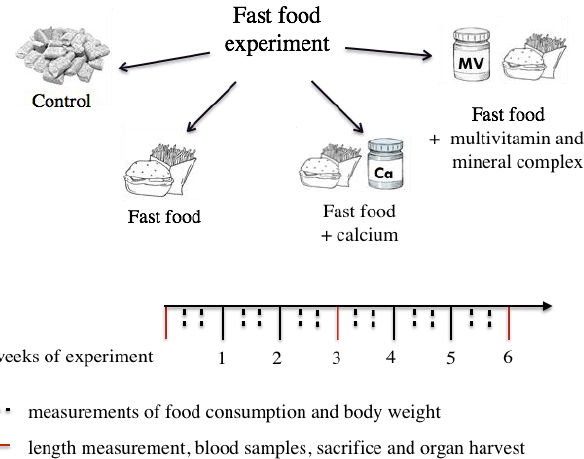
Figure A1. Experimental design and timeline with two end points—at 3 and at 6 weeks of the ex- periment.